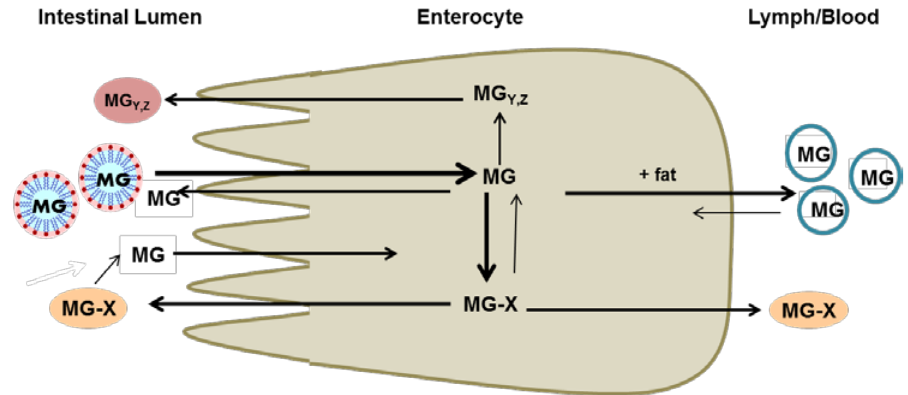
Figure 3. Transport and metabolism of mangosteen xanthones across intestinal epithelium. MG: xanthones; MG-X: xanthone phase II metabolites; MG of